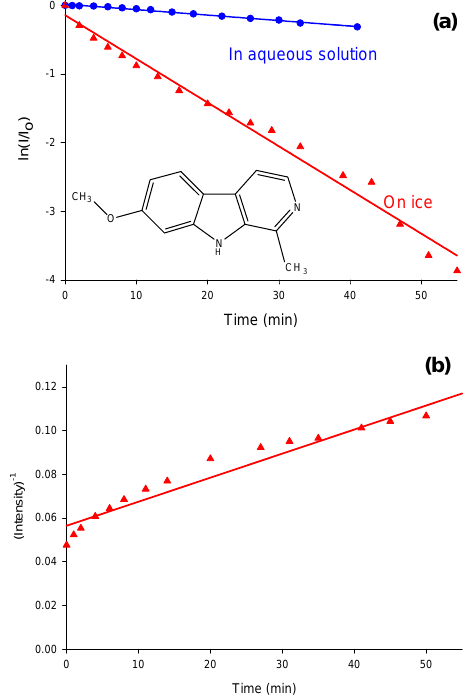
Figure 2 Fig. 2. (a) Loss of harmine emission intensity as a function of irra- diation time in aqueous solution and at an air-ice interface shown as semi-log plots (first-order kinetics). The solid traces are linear fits to the data. The inset displays the chemical structure of harmine; (b) the change in (harmine emission intensity) − 1 as a function of irradiation time at an air-ice interface (second-order kinetics). The solid trace is a linear fit to the